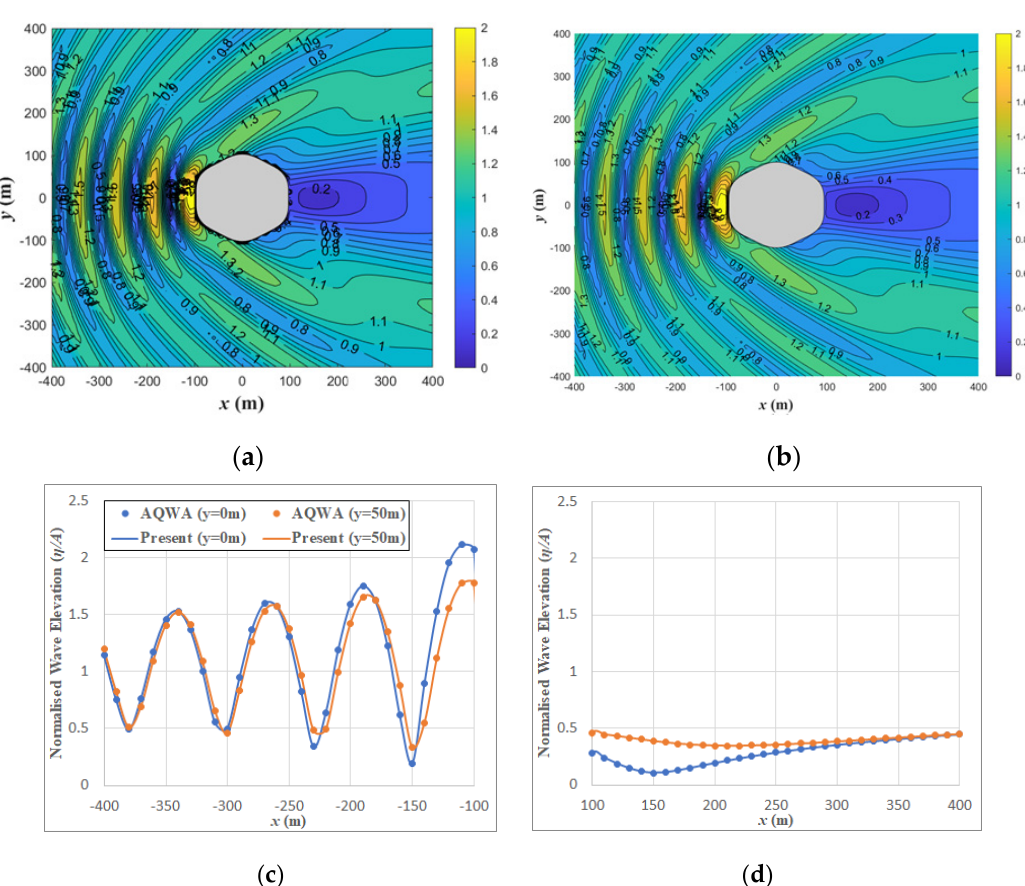
Figure 5. Comparison of normalised wave elevations obtained from AQWA and semi-analytical approach (for T = 5 s): ( a ) wave field from semi-analytical approach; ( b ) wave field from AQWA; ( c ) wave profiles in the sea side; and ( d ) wave profiles in the lee side.